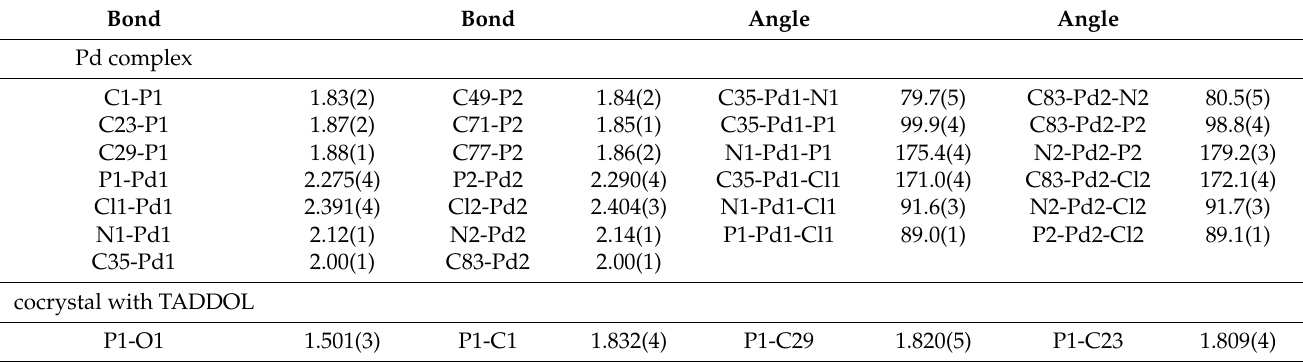
Table 19. Bond lengths (Å) and angles ( ◦ ) for Pd complex and cocrystal of 9 with